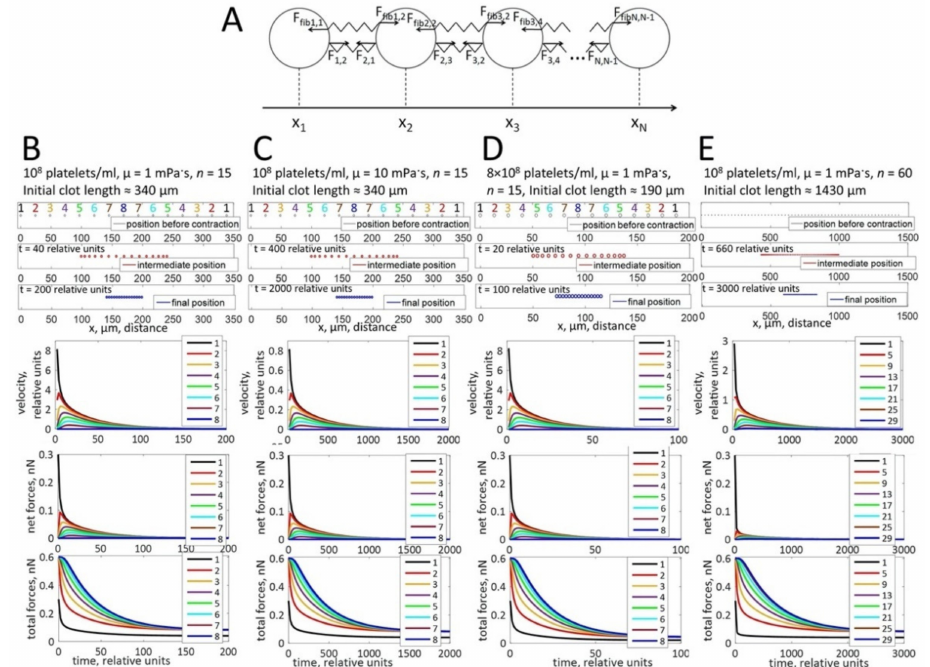
Figure 2. Computational modeling of platelet distributions in a one-dimensional, unconstrained clot. ( A ) Schematic representation of the modeled system. Platelets are depicted as circles, connected by elastic springs. F i,j is the force exerted on a platelet i by a neighboring platelet j pulling on the adjacent fibrin stands. F fibi,j is the force exerted on a platelet i by the compressed fibrin gel. The forces change with the distance between platelets (|x j − x i |) according to Hooke’s law. ( B – E ) The modeling approach simulates platelet distributions after contraction. Black ovals—initial state of platelet distribution. Blue ovals—platelet distribution after contraction, indicating that the platelets are located uniformly in the retracted clot. Simulations of platelet velocities (upper graphs), net forces (the vector sum of forces that act on a platelet; middle graphs), and total forces (the algebraic sum of all forces that act on a platelet; lower graphs) are shown for different platelet concentrations, different viscosities of the fibrin network ( µ ), or different clot sizes as indicated at the top of panels B-E. For all conditions, platelets at the border of the thrombus move faster than platelets in the center. The platelet velocity decreases exponentially with time of contraction. Net forces that act on the peripheral platelets are higher than net forces in the center of the clot. In contrast, total forces are higher in the center than in the periphery. Forces are not influenced by the viscosity of the fibrin network and the platelet concentration. Velocities decrease when the viscosity of the fibrin network